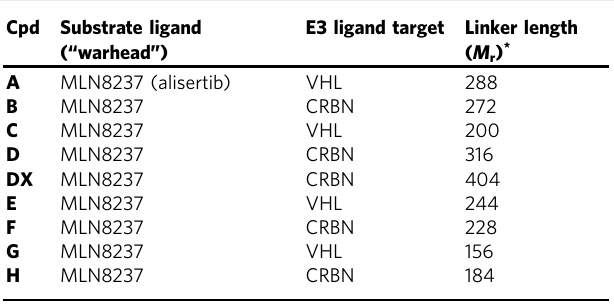
* M r relative molecular